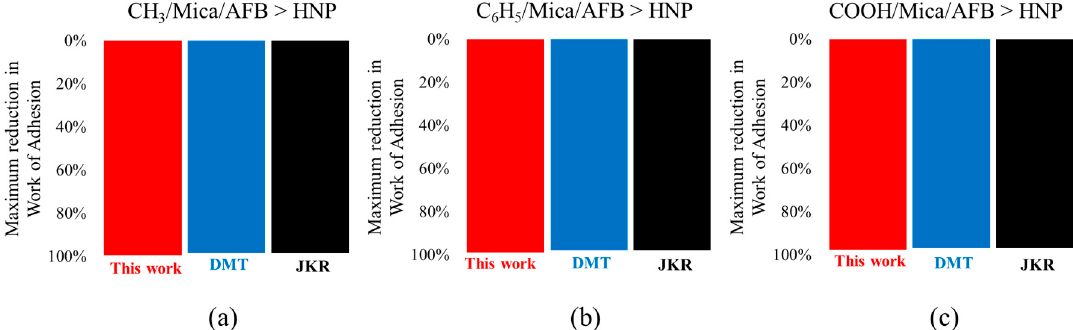
Figure 14. Maximum reduction in the work of adhesion between mica and functional groups using hydrophilic silica nanofluids (HNP) in place of artificial formation brine (AFB). Maximum decrease obtained in this study for ( a ) -CH 3 tip on mica was 99%, compared to 98% based on JKR [57] and DMT [58] models respectively, ( b ) for -C 6 H 5 tip on mica it was 99%, compared to 98% based on JKR [57] and DMT [58] models, and ( c ) for -COOH tip on mica, it was 98%, compared to 97% based on JKR [57] and DMT [58] models.